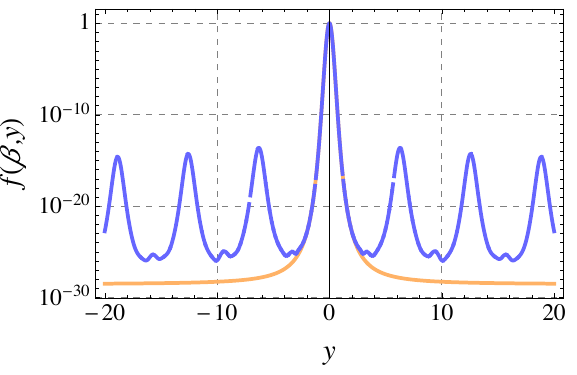
Figure 3. Spectral form factor f ( (cid:12); y ) for the holographic CFT. In the numerically exact result (in blue) using (7.33), the contribution of the sum over saddles is subdominant and orders of magnitude smaller than that of the leading one